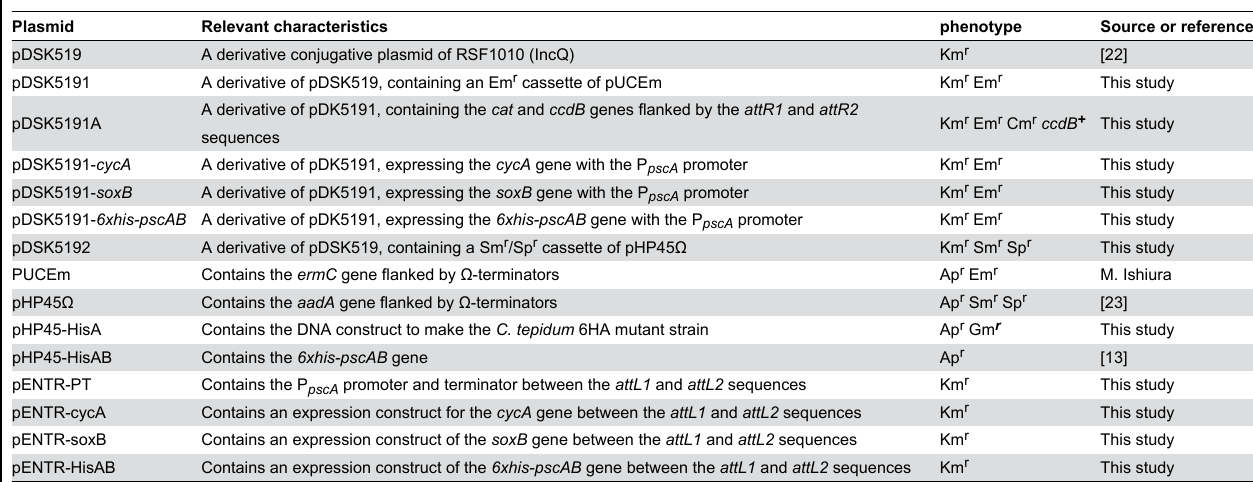
Table 2. Plasmid used in this